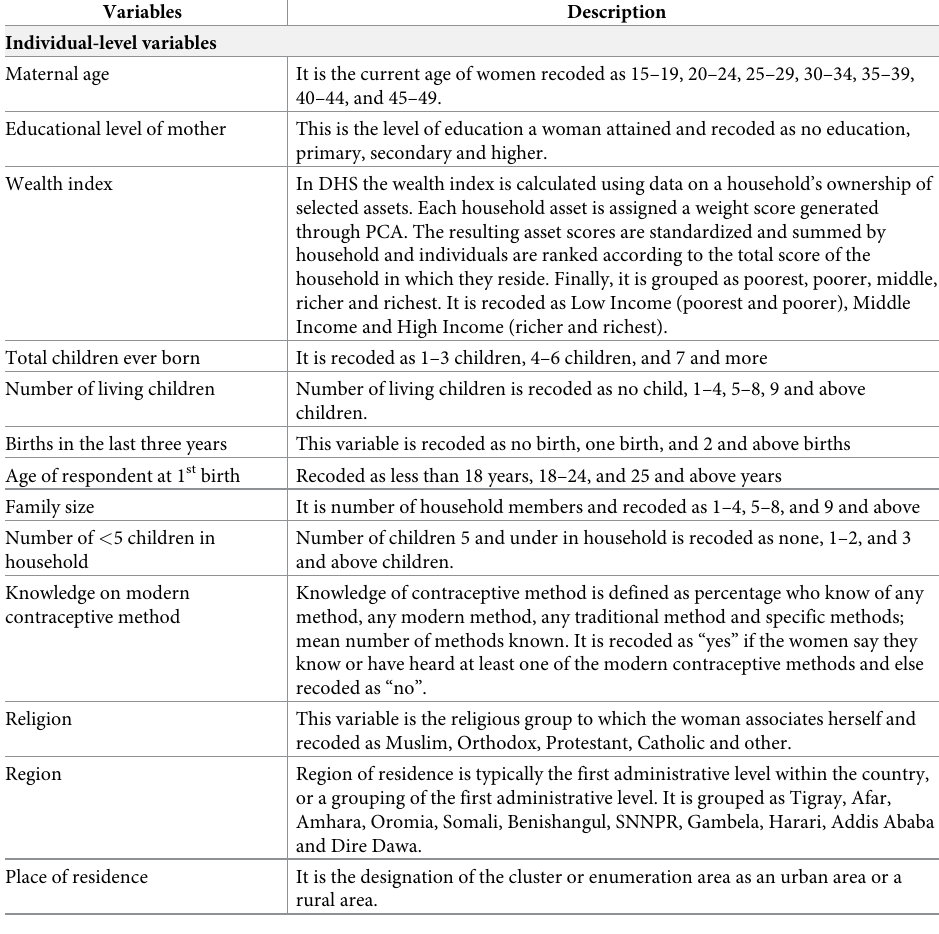
Table 1. Description of individual and community level